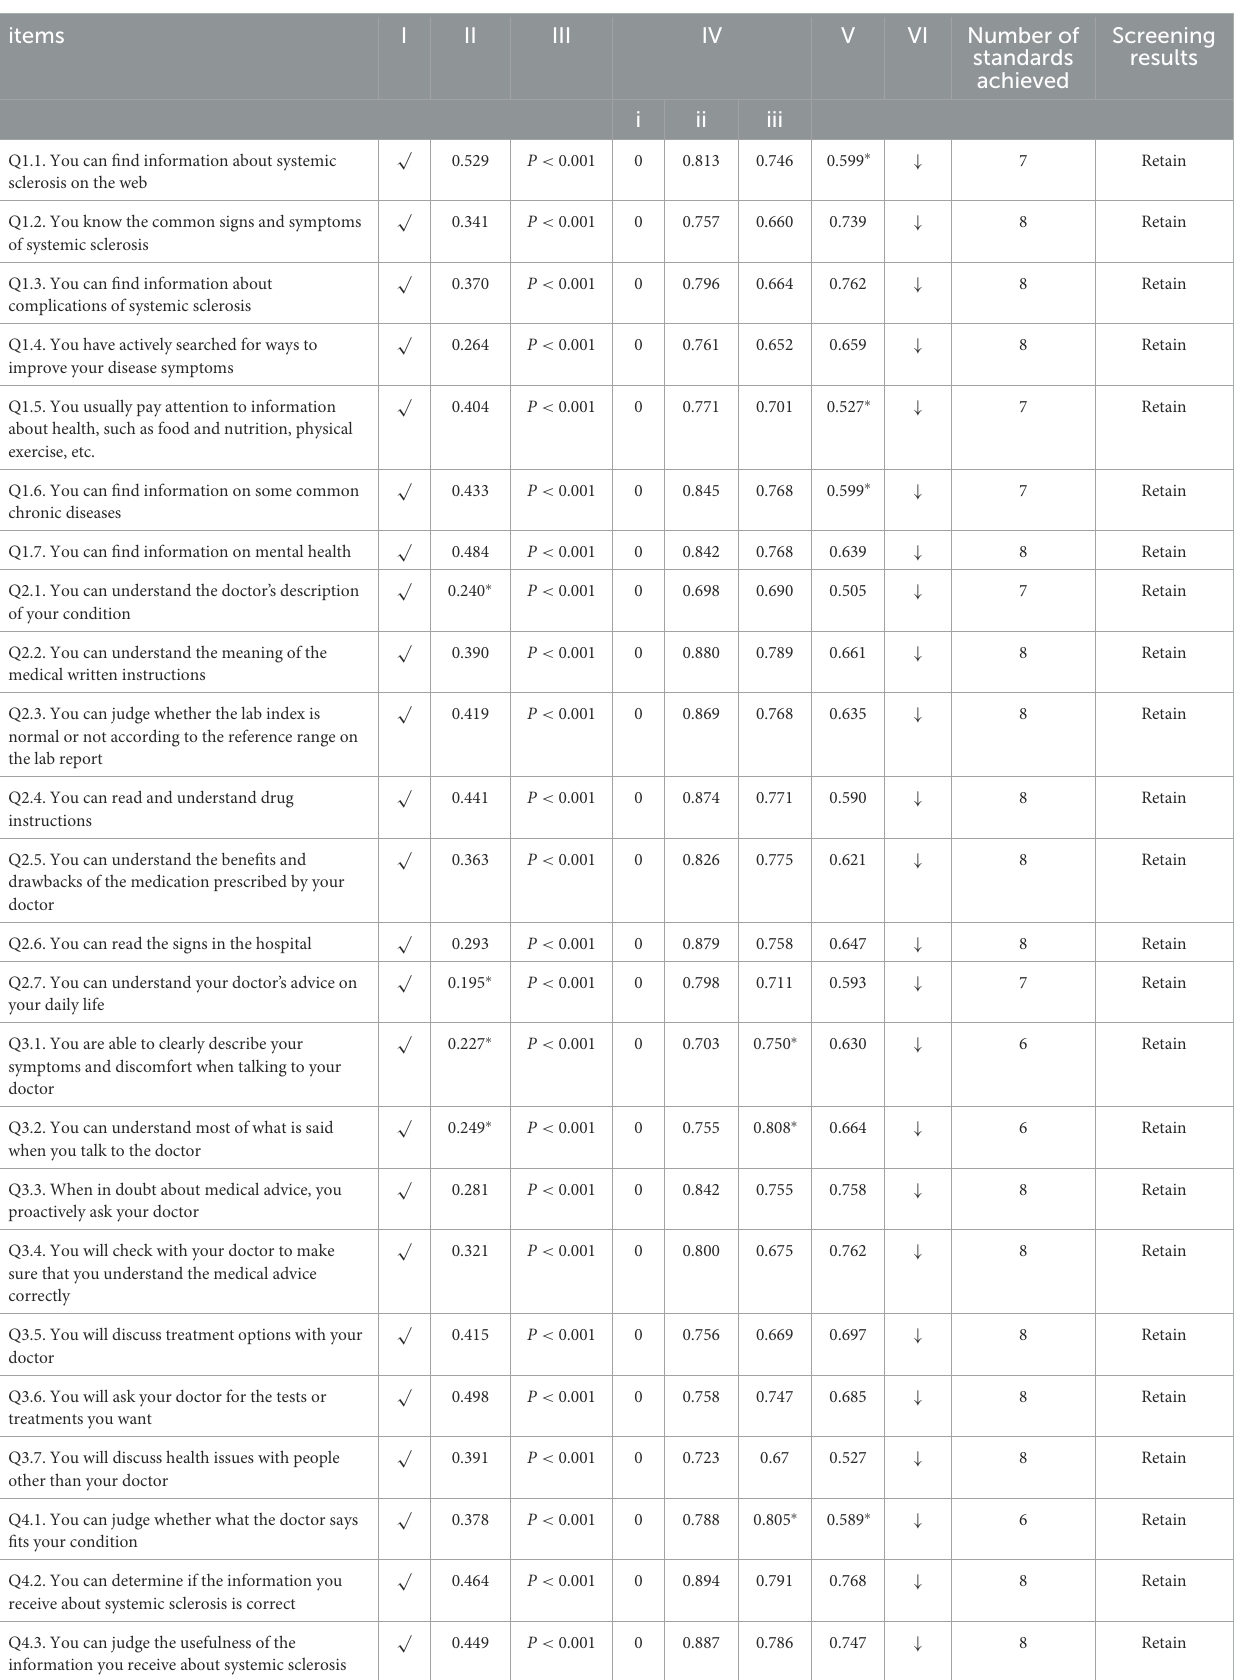
TABLE 2 Summary of items screening results.